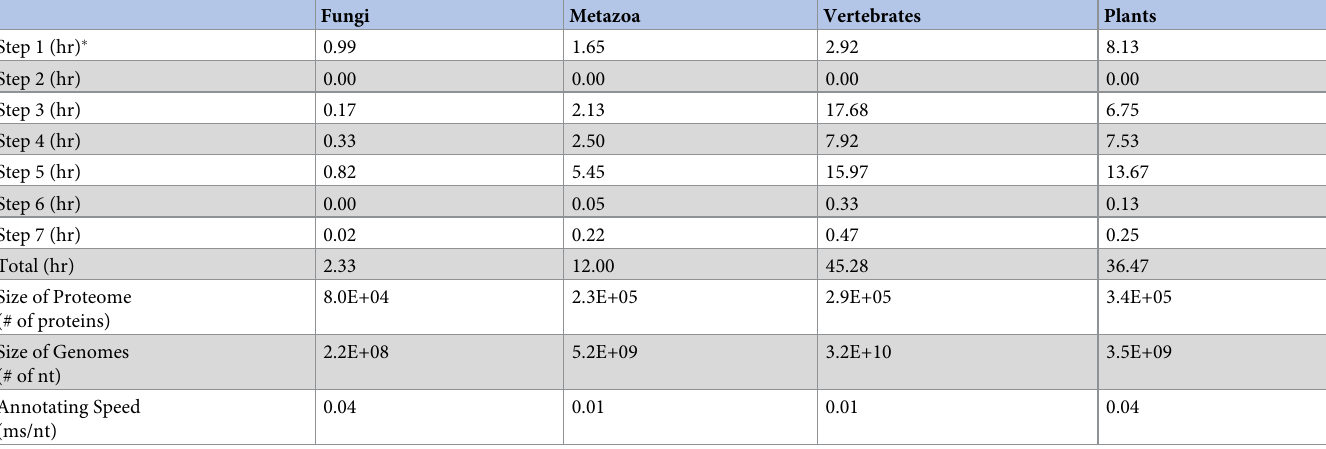
Table 7. Performance benchmark test of CTT in annotating Pkinase genes in 40 genomes.